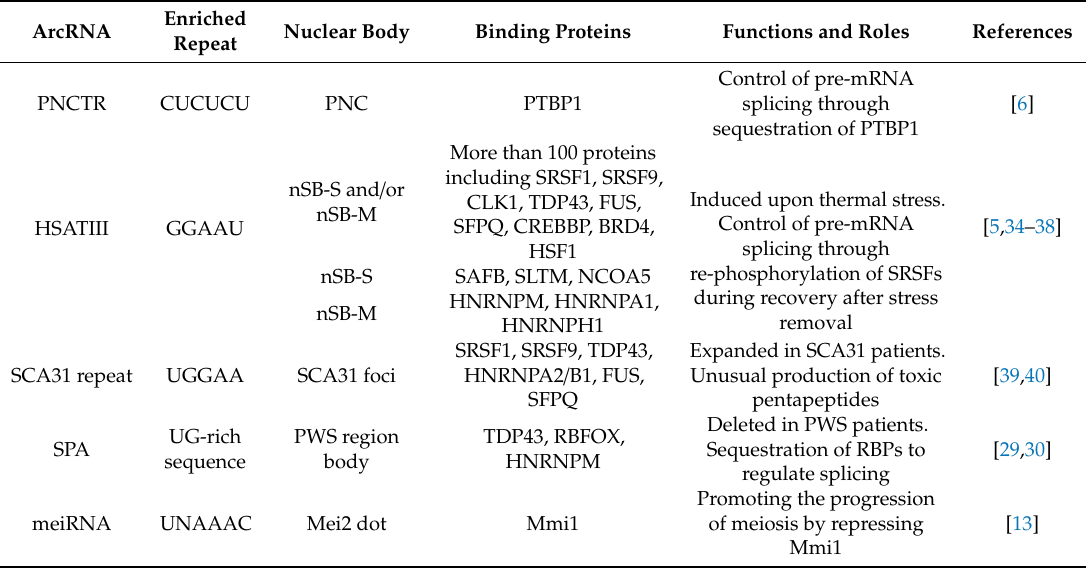
Table 1. List of short tandem repeat-enriched